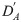
Temporal sensing is favored at high ratio of cell speed over cell size.Percentage of runs where temporal sensing yield high output (green) or spatial sensing yield high output (red) for (a) incoherent feedforward and (b) negative integral feedback circuits at different values of β. The range of DA′ and DB′ values used are DA′=0.1,1.0,10,100,1000 and DB′=0.1,1.0,10,100,1000. (c) Dynamics of the average level of protein C (red), level of protein C at the front (green) and back (blue) for different values of β for the incoheret feedforward circuit with DA′=DB′=1.0. (d) Output from temporal (green) and spatial sensing (red) for the different values of β.